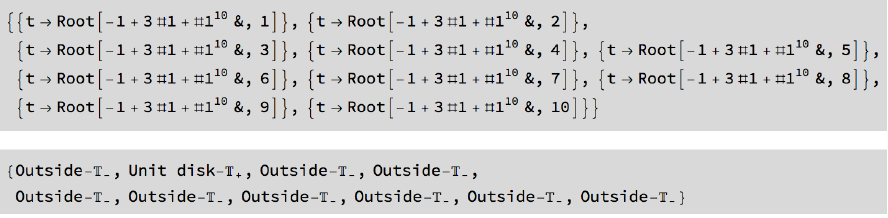
Figure 43. Output given by the [AZeros] algorithm.